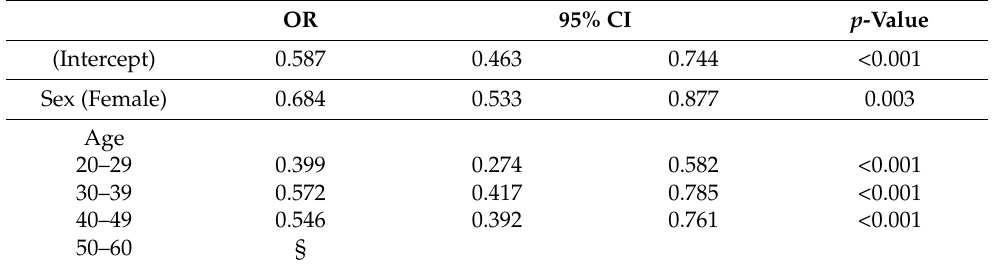
Table 2. Vaccination regimen chosen by sex and age (all participants): generalized linear model.